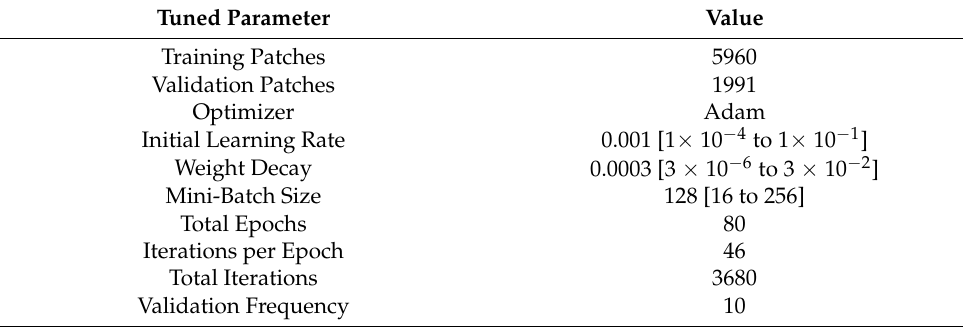
Table 2. AUnet training